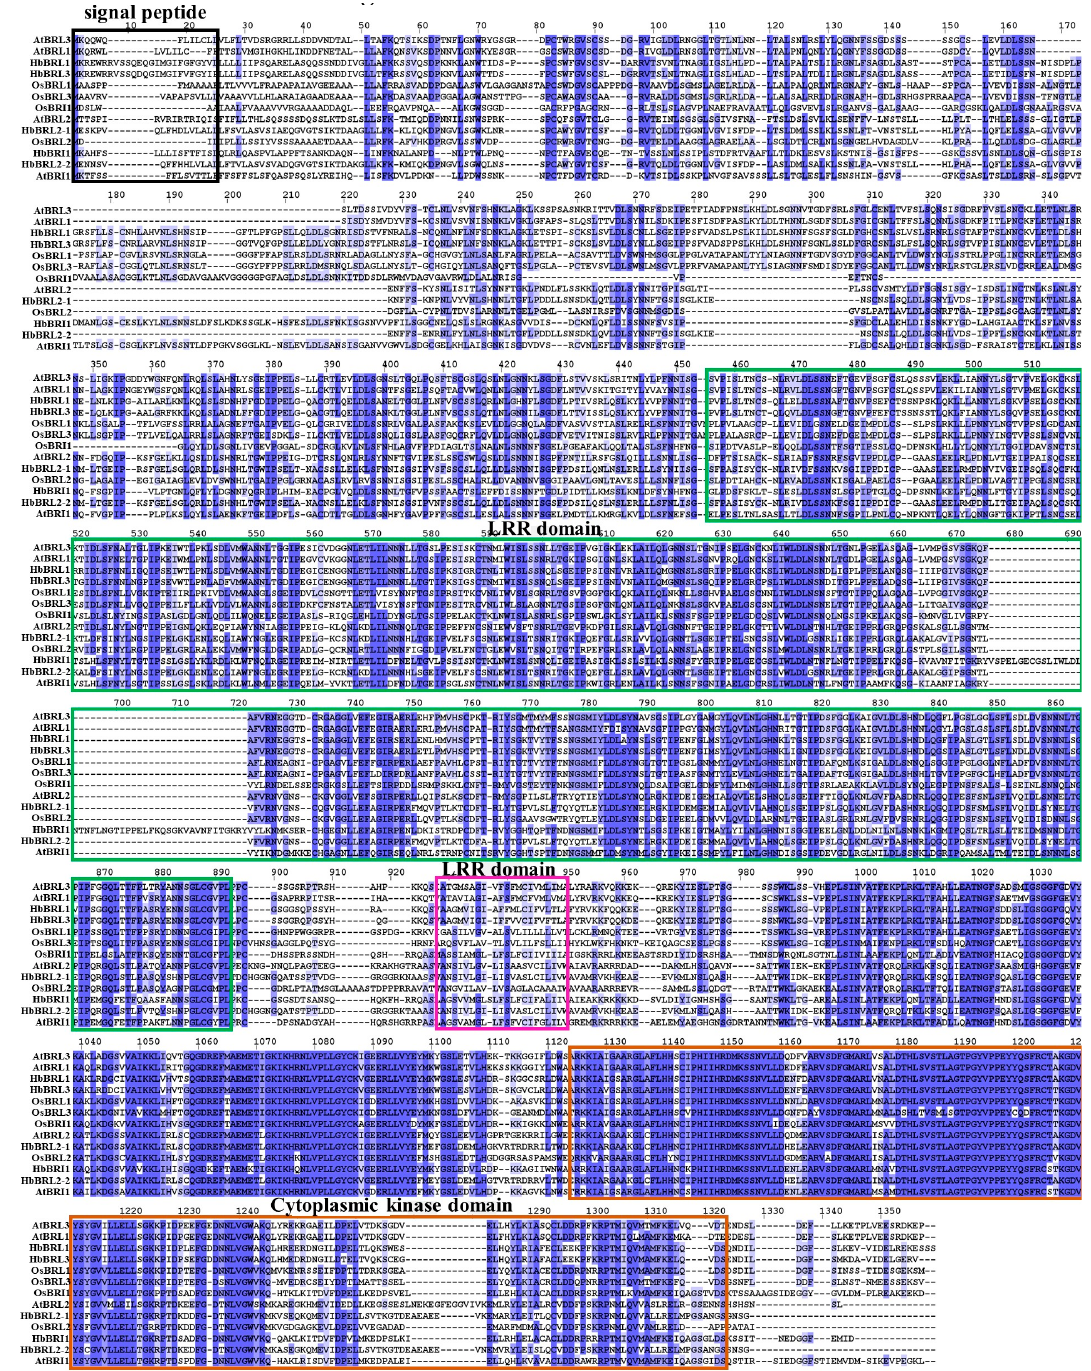
Figure 2. Multiple alignments of the HbBRI1 domains. Conserved domains of HbBRI1 amino acid sequences are marked in colored rectangles: signal peptide (black), LRR domain (green), transmem- brane domain (rose red) and serine/threonine kinase domain (brown).